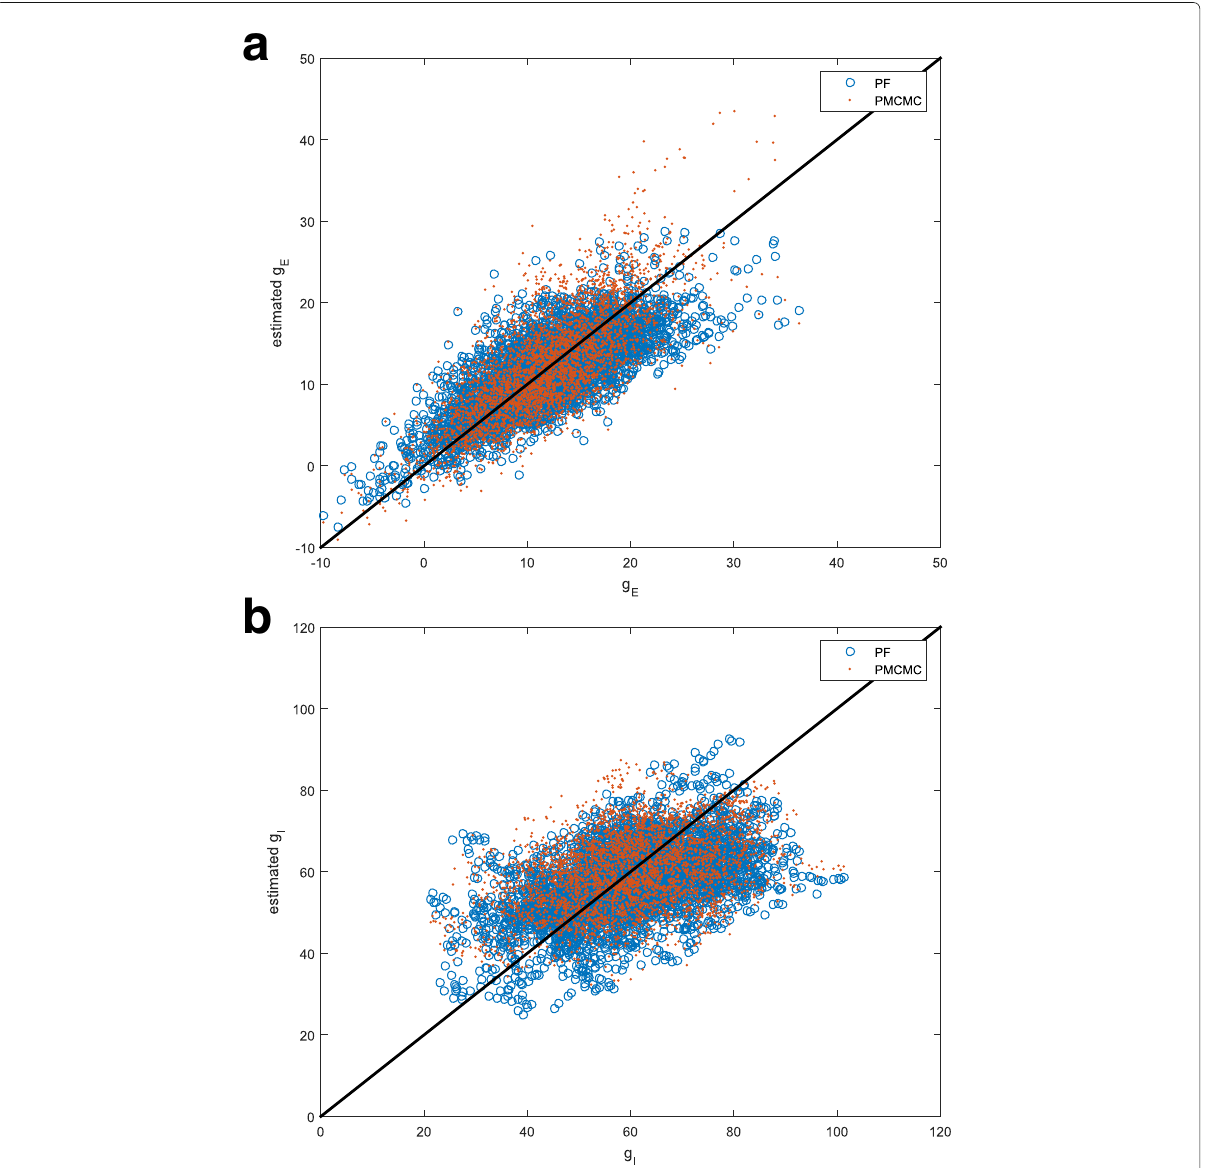
Fig. 10 Comparison of estimated excitatory ( a ) and inhibitory ( b ) synaptic conductances versus the actual ones. We show both the performance of the PF method (round circles), which assumes a perfect knowledge of the model, and the PMCMC method (red